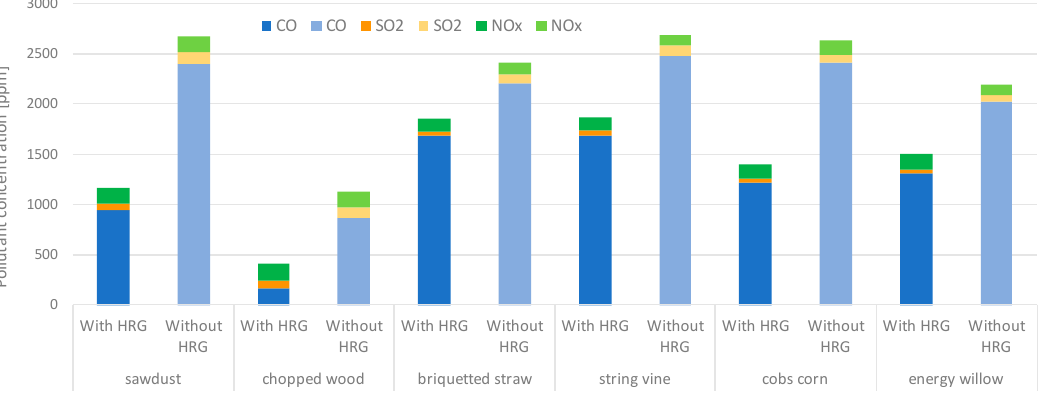
Figure 18. Concentration of pollutants.